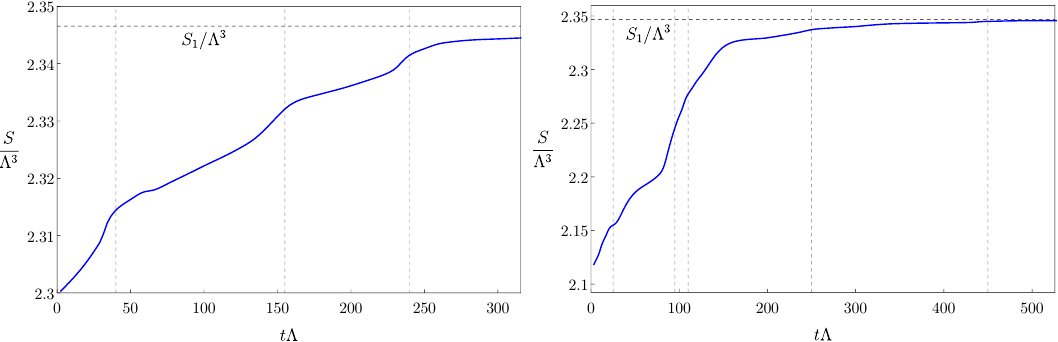
Figure 23 . Time evolution of the total entropy (per unit transverse area) for the evolutions of figure 19 with v max = 0 . 25 (left) and v max = 0 . 73 (right). S 1 is the entropy of a static configuration with the same total energy but a single domain. The vertical dashed lines represent the approximate time of each